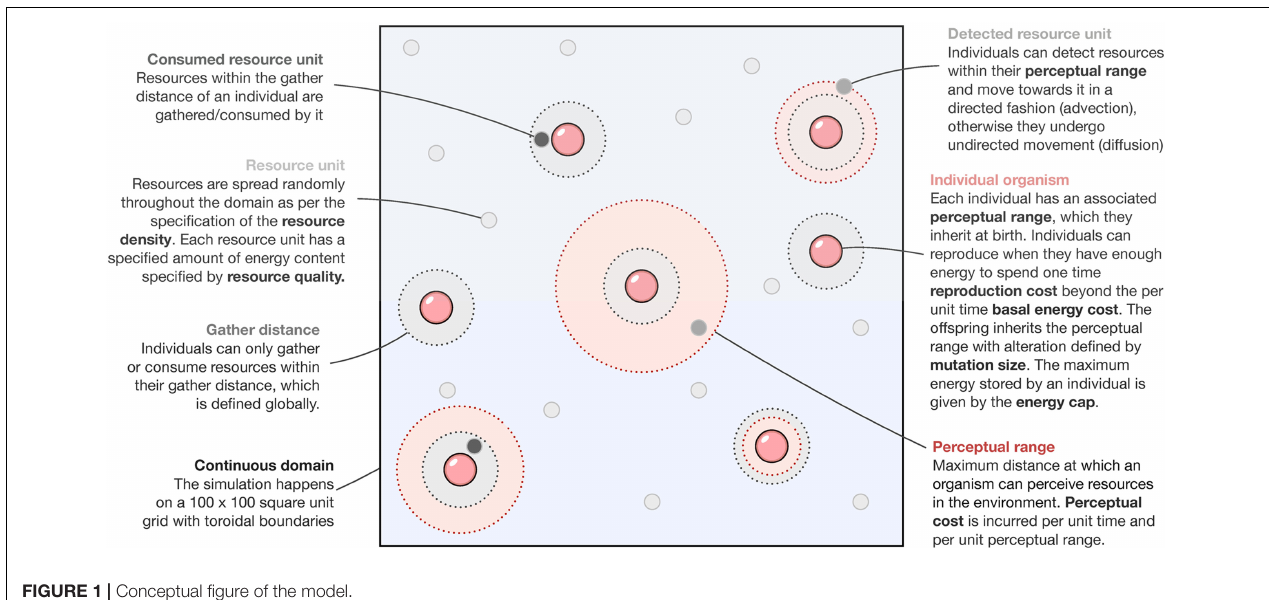
FIGURE 1 | Conceptual figure of the model. TABLE 1 | Summary of various parameters used in the model, their definitions and their effects on the perceptual range